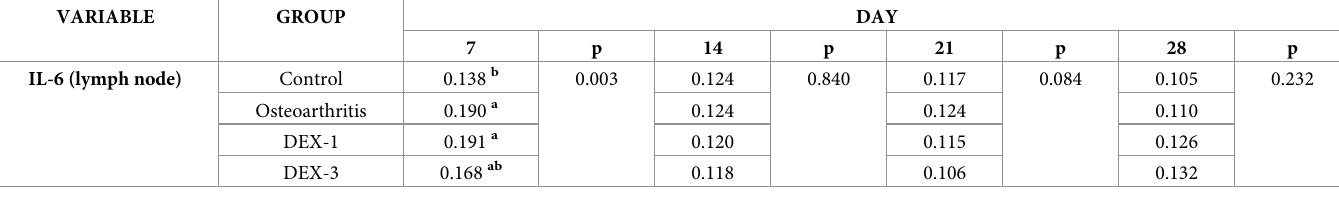
NOTE a, b Different letters represent p < 0.05 by Dunn’s test.